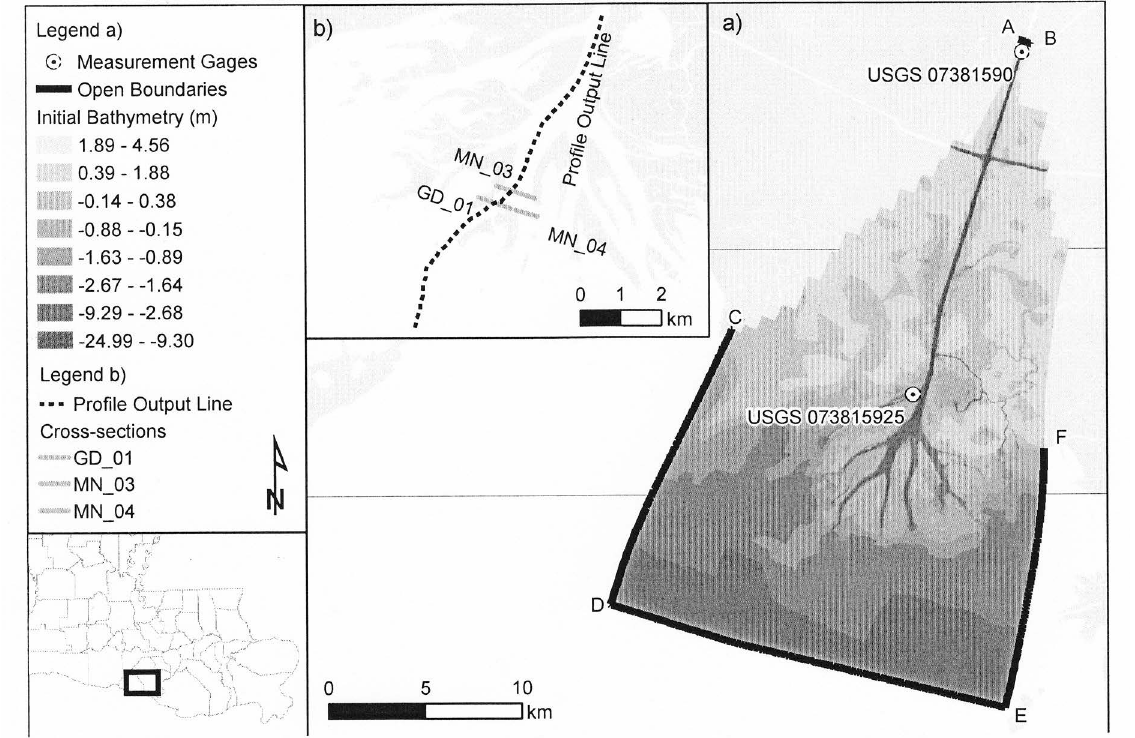
Fig. 1 (a) Wax Lake Delta Delft3D model domain and initial bathymetry. Model open boundaries are indicated by thick black lines. Line A–B is the upstream flow boundary. Line D–E is the offshore water level boundary, forced with astronomical constituents that vary linearly along the boundary. The lateral boundaries at lines C–D and E–F are assigned Neumann conditions where the water surface gradient along the boundaries is equal to zero. Locations of USGS flow and water level measurement gauges used in model development and calibration are also shown. (b) Locations of sediment flux transects (labelled MN_03, GD_01, and MN_04) and streamwise profile output line within Wax Lake Delta model. Flux through the transects is shown in Fig. 3, and various quantities along the profile output line are plotted